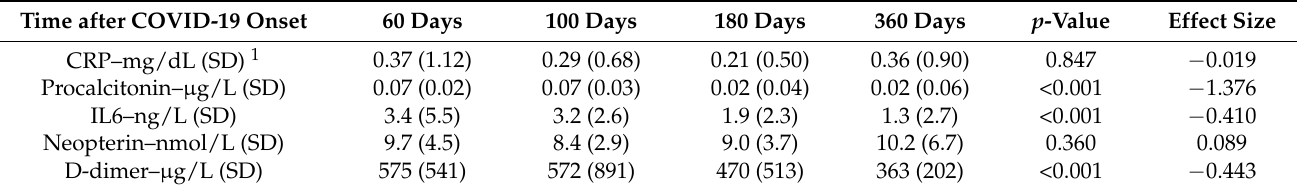
Table 3. Time course of serum markers of thrombo-inflammation in the CovILD cohort. Time after COVID-19 Onset 60 Days